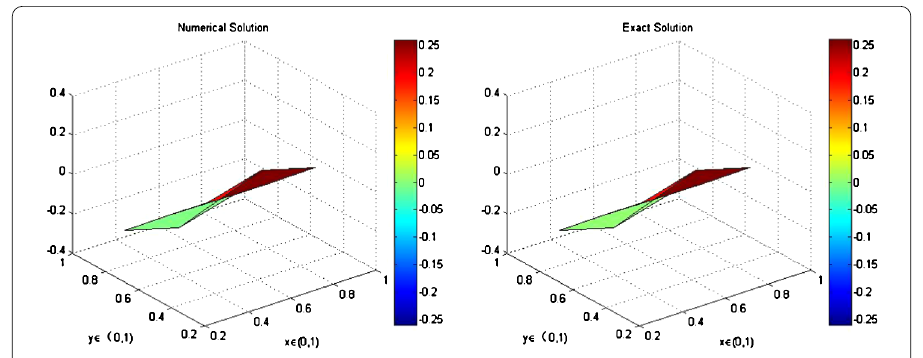
Figure 9 The effect of numerical solution and exact solution at fixed T = 1, h = 1 ( a ) N = 2 2 . ( b ) N = 2 2